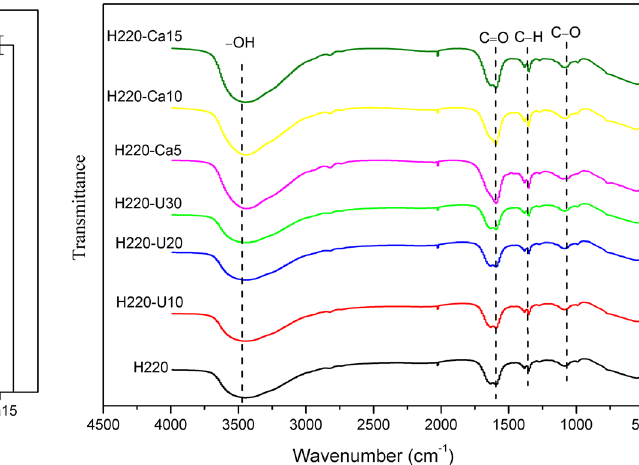
Figure 5: FTIR spectra of di ff erent hydrochar after the adsorption of Pb 2 +